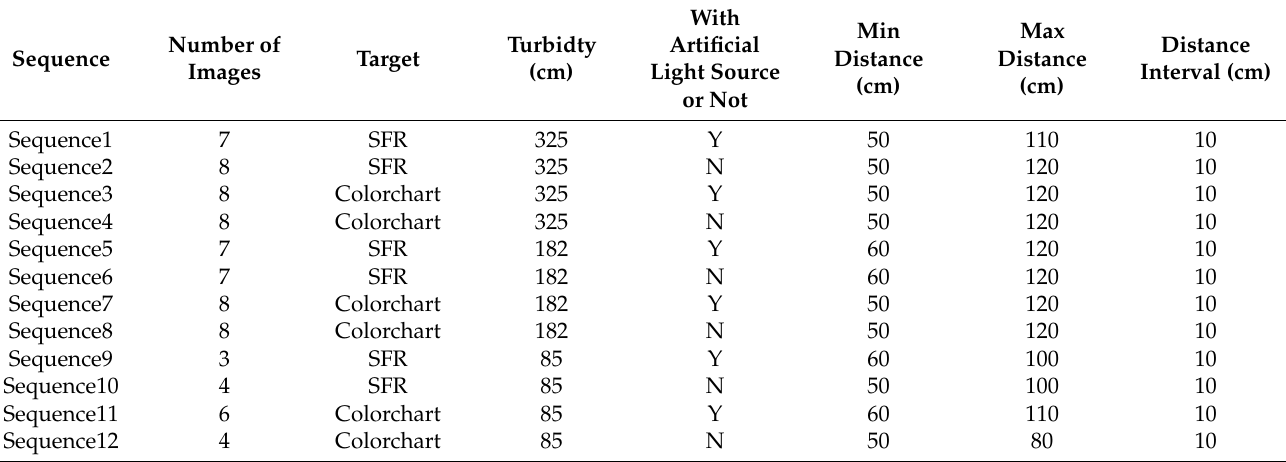
Table 2. Relevant information of images in